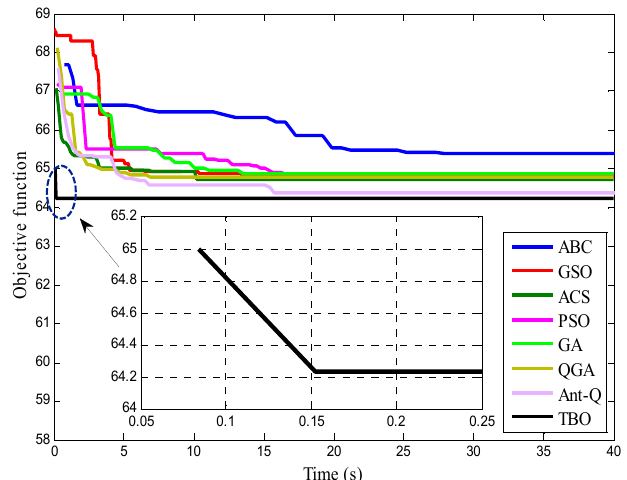
Figure 8. Convergence of the second new task of the IEEE 118-bus system obtained in the online optimization.